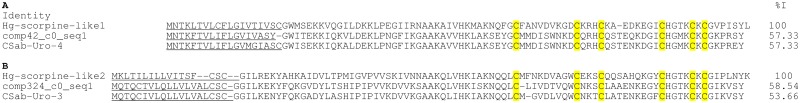
Scorpine-like peptides found in the Urodacus yaschenkoi transcriptome.A) The sequence obtained from the U. yaschenkoi transcriptome that codifies for a scorpine type 1 is shown and it is aligned with the reference scorpine Hg-scorpine-like1 from Hadrurus gertschi. Sequence CSab-Uro-4 from Urodacus manicatus [49] codifies as well for a scorpine type 1 and is included in the alignment. B) The sequence comp324_c0_seq1 found in the U. yaschenkoi transcriptome that codes for a scorpine type 2 is shown and aligned with Hg-scorpine-like2 from H. gertschi. Also, sequence CSab-Uro-3 from U. manicatus [49] is included. Both alignments show the percentage of identity of each sequence with respect to the reference sequence. The cysteine pattern (6 Cys) is highlighted in yellow. Note: comp42_c0_seq1 and comp47_c0_seq1 (not shown) code for the same precursor, comp324_c0_seq1 and comp336_c0_seq1 (not shown), code for the same precursor.